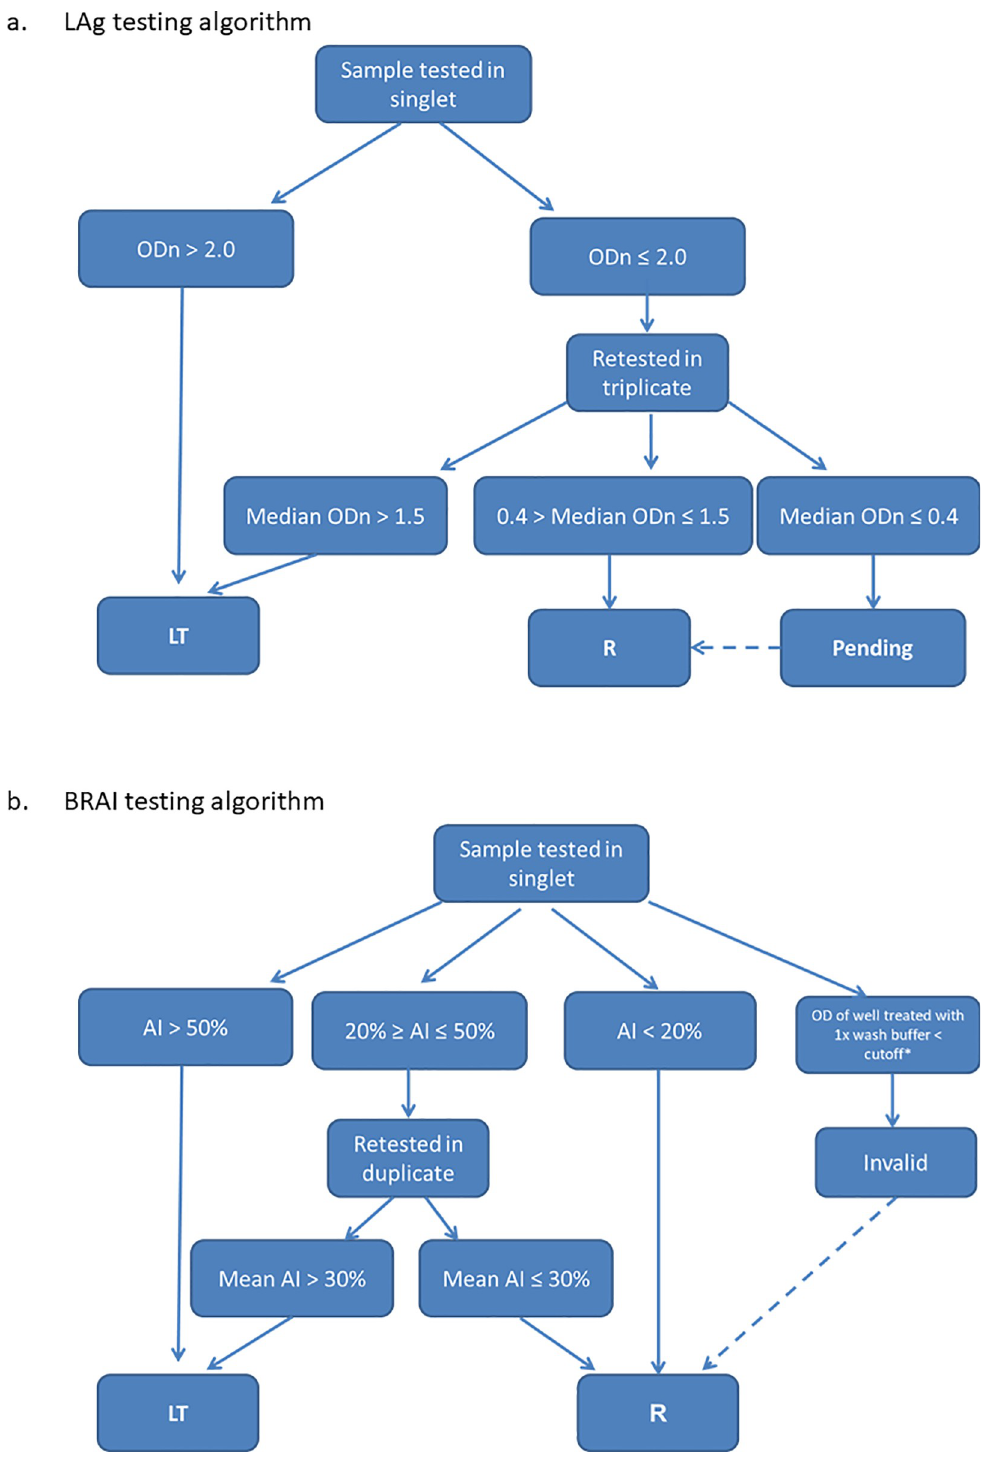
Fig 1. Testing algorithms for determination of recent (R) and long-term (LT) HIV-1 infections by the (a) LAg and (b) BRAI avidity assays. Dashed arrows in the algorithms indicate that all specimens classified as LAg-pending were reclassified as R because all samples were collected from persons confirmed to be HIV-positive and all BRAI-invalid results were reclassified as R because all samples were collected from individuals who were confirmed to have HIV infection, were treatment na ï ve and not classified as having AIDS. � BRAI cut-off is the mean of the optical density of the assay negative controls plus 0.250. ODn, normalized optical density. https://doi.org/10.1371/journal.pone.0217048.g001 PLOS ONE | https://doi.org/10.1371/journal.pone.0217048 May 24,